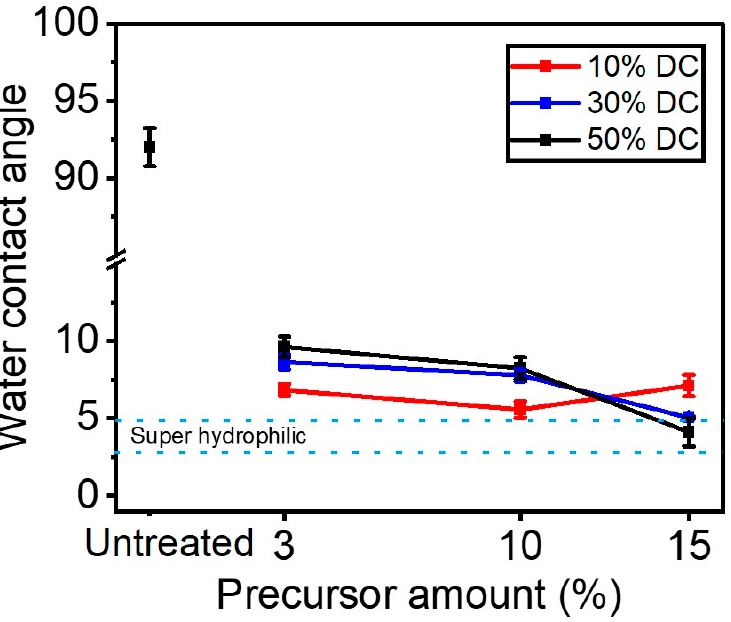
Figure 6. Water contact angle as a function of the precursor (e.g., 3%, 10%, 15%) for different DCs (e.g., 10%, 30%,